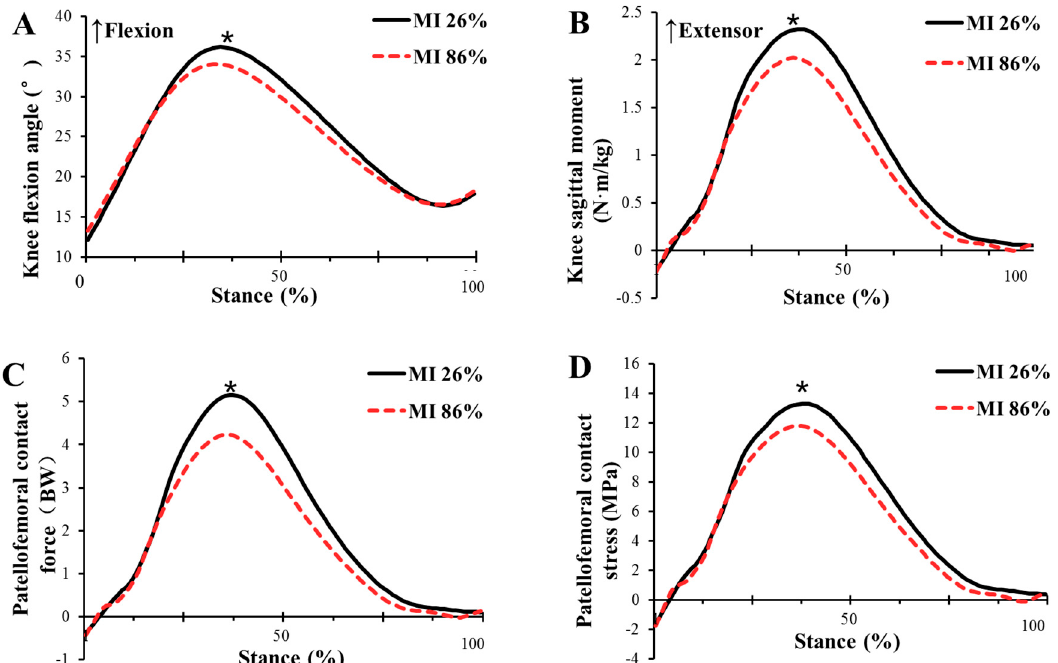
Figure 4. Comparison of the mean values of knee kinematics and kinetics from all participants between shoe conditions (MI 26%: cushioned shoes; MI 86%: minimalist shoes). ( A ) knee flexion angle during stance phase; ( B ) knee sagittal moment during stance phase; ( C ) patellofemoral contact force during stance phase; ( D ) patellofemoral contact stress during stance phase. * P < 0.05.